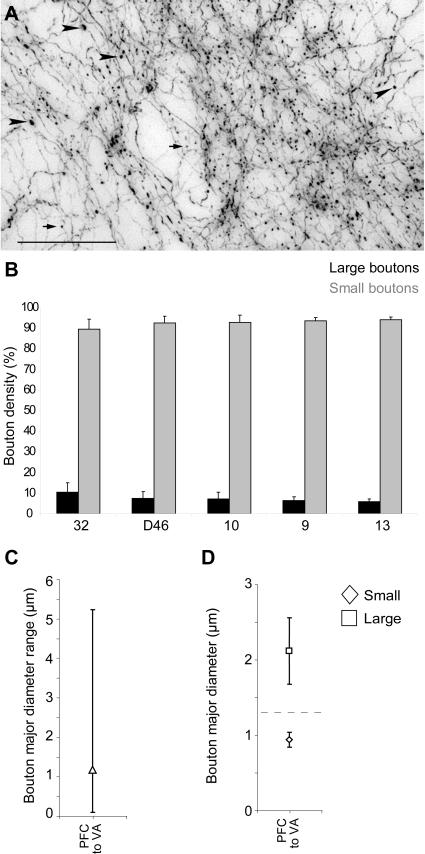
Bouton population analysis of prefrontal terminations in the ventral anterior thalamic nucleus.
A, The dimorphism of sizes of boutons from prefrontal projections to the ventral anterior nucleus. Brightfield photomicrograph showing BDA-labeled prefrontal axons and boutons from area 32 terminating in the ventral anterior nucleus, as large boutons (black arrowheads), or small boutons (black arrows). Scale bar: 50 µm. B, Large and small axonal bouton populations from prefrontal cortices in the ventral anterior nucleus. Normalized density (%) of large and small boutons in the ventral anterior nucleus from prefrontal axons. C, Mean major diameter of boutons from axons originating in prefrontal cortices and terminating in the ventral anterior nucleus. Range of diameters of boutons is also indicated (vertical lines). D, Cluster analysis of the diameter of boutons (± variance) emanating from prefrontal cortices and terminating in the ventral anterior nucleus (VA).